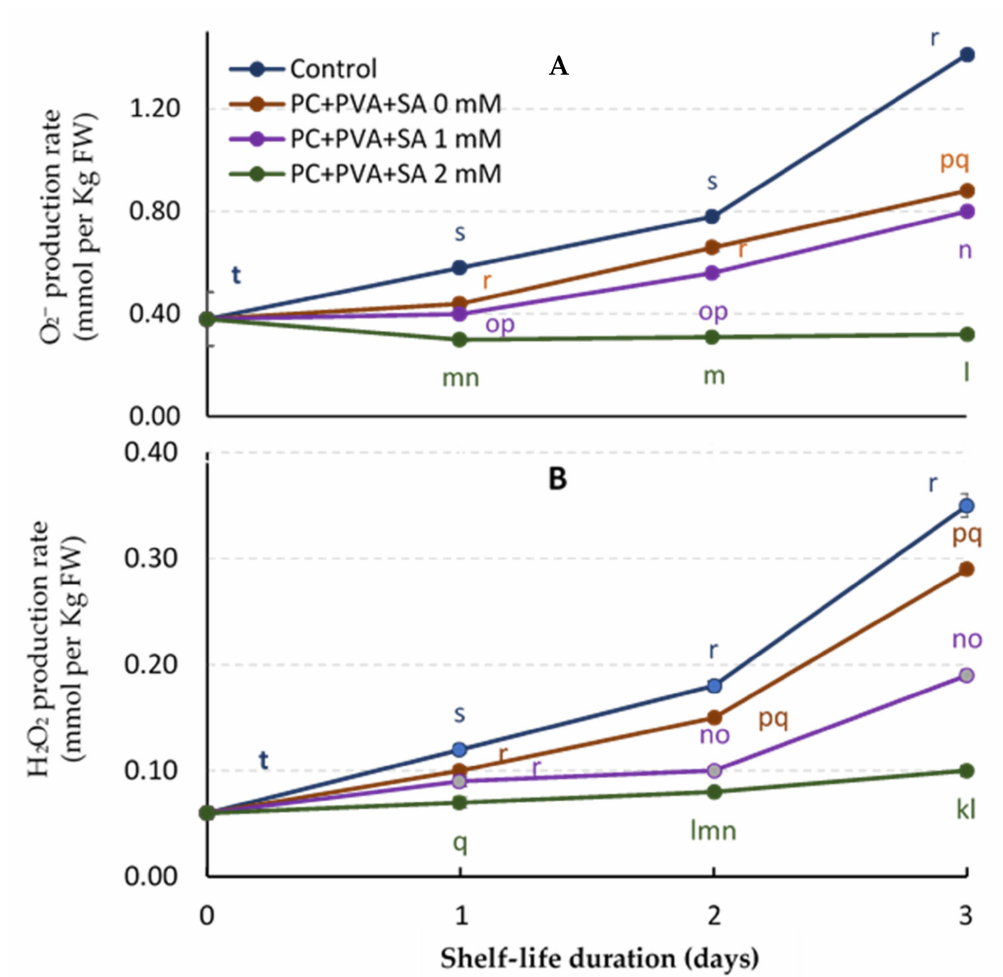
Figure 8. O 2 − ( A ) and H 2 O 2 ( B ) production rates of ‘Crimson seedless’ grapes coated with PE + PVA blending with SA at different concentrations (0, 1, and 2 mmol L − 1 ) and stored at room temperature (26 ± 1 ◦ C and 65 ± 5% RH) for 3 d. Each value represents a mean of three replicates, with error bars representing standard errors ( ± SE), and different letters indicate significant differences at p ≤ 0.05 between treatments. Mean comparisons were performed between all